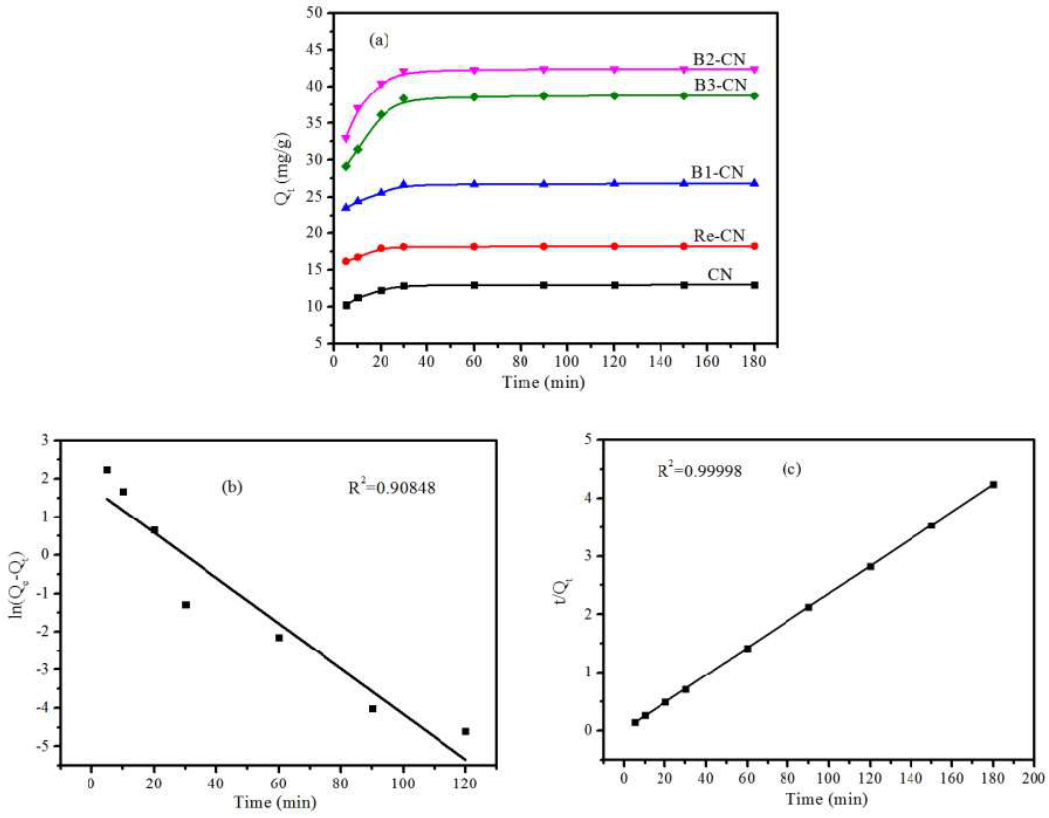
Figure 10. Adsorption kinetics curves for all samples ( a ); plots of the pseudo first order ( b ); plots of the pseudo second order ( c ).